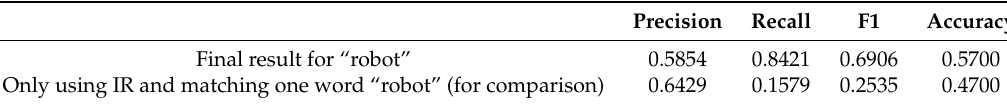
Table 12. Precision, recall, F1, and accuracy for test